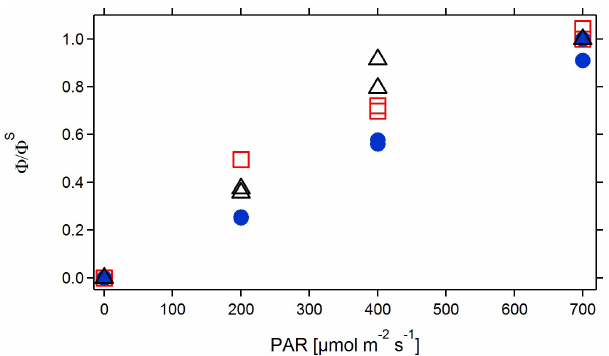
Figure 6. Temperature coefficient β for α -pinene emissions from Holm oak (experiment 3) at different soil moisture. Black cir- cles represent the data obtained without impacts of drought on MT emissions. Red squares represent the data obtained for (cid:50)< 0.06m 3 × m − 3 after correcting for the drought-induced de- crease of emissions. Errors in β were about ± 0.01K − 1 for the data obtained without drought stress. For the data obtained during drought stress the errors from the normalization procedure had to be taken into account and errors in β are estimated to be ± 0.03K − 1 . Error in (cid:50) is estimated to be ± 0.016m 3 × m − 3 .